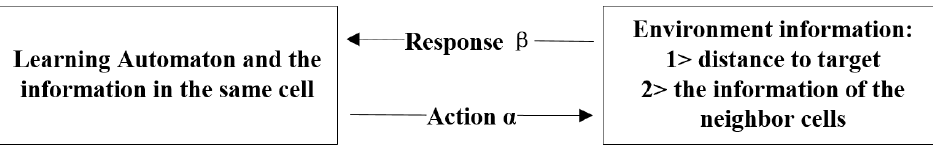
Figure 4. Relationship between the LA and the environment.